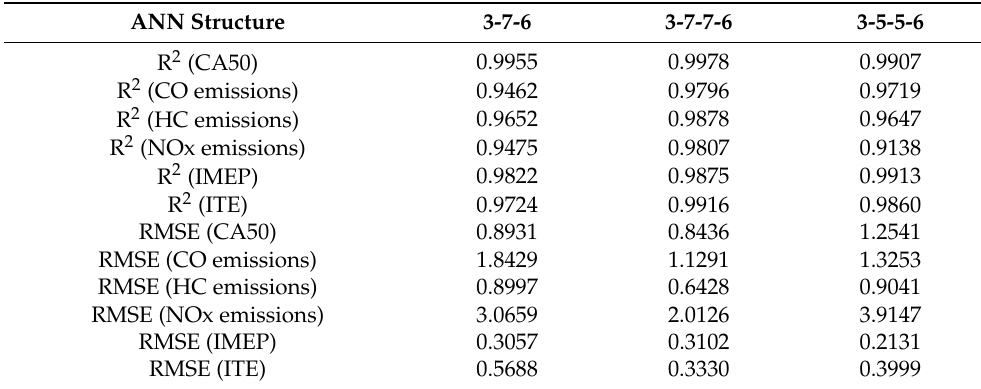
Table 4. The R 2 coefficient and RMSE calculated for the validation dataset based on the different structures of the ANN